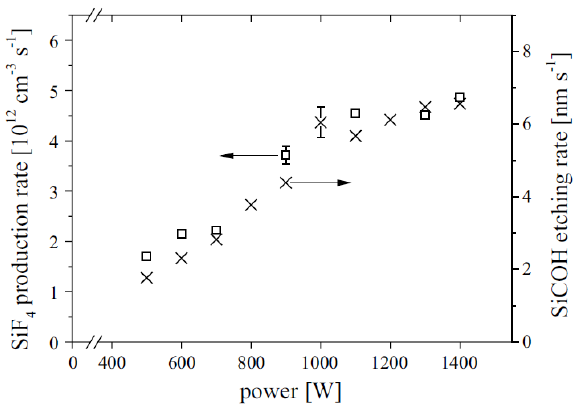
Figure 17. Production rate of SiF 4 and the etching rate of SiCOH dependence on power (CF 4 plasma, φ = 12 sccm, p = 0.93 Pa) [58], © Springer Publishing. Reproduced with permission. All rights reserved.